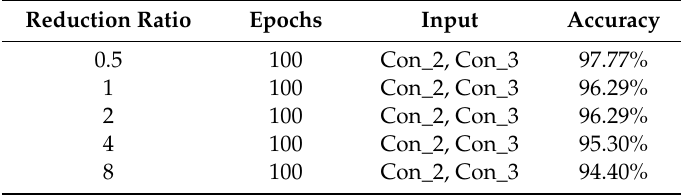
Table 3. Comparison between SSE module at di ff erent reduction